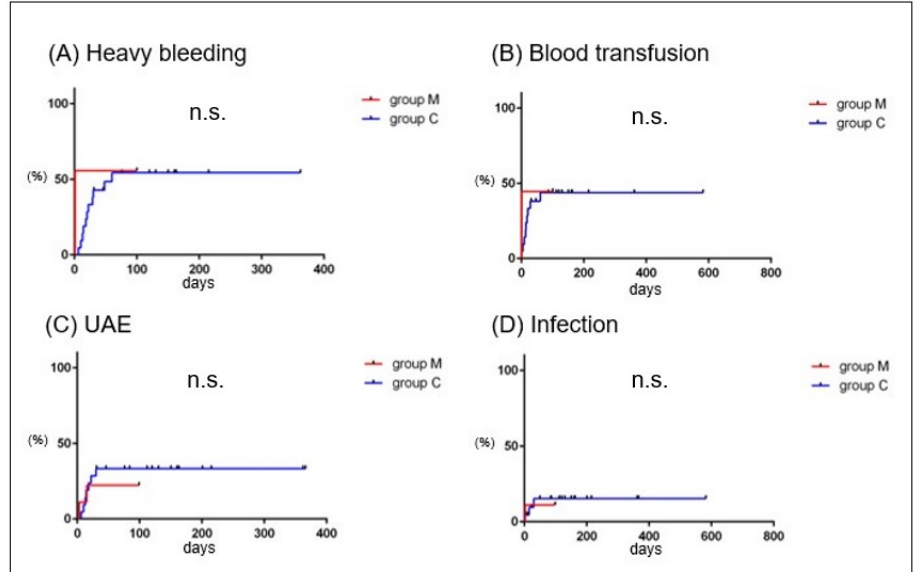
Figure 5. The cumulative incidence rate of events in Group M and Group C. The horizontal and vertical axes represent the duration from delivery to the onset of the events (days) and the incidence rate (%), respectively. Red lines and blue lines show cumulative incidence rates of heavy bleeding ( A ), blood transfusion ( B ), UAE ( C ), and infection ( D ) in Group M ( n = 9) and Group C ( n = 22). RPOC: retained products of conception; UAE: uterine artery embolization.